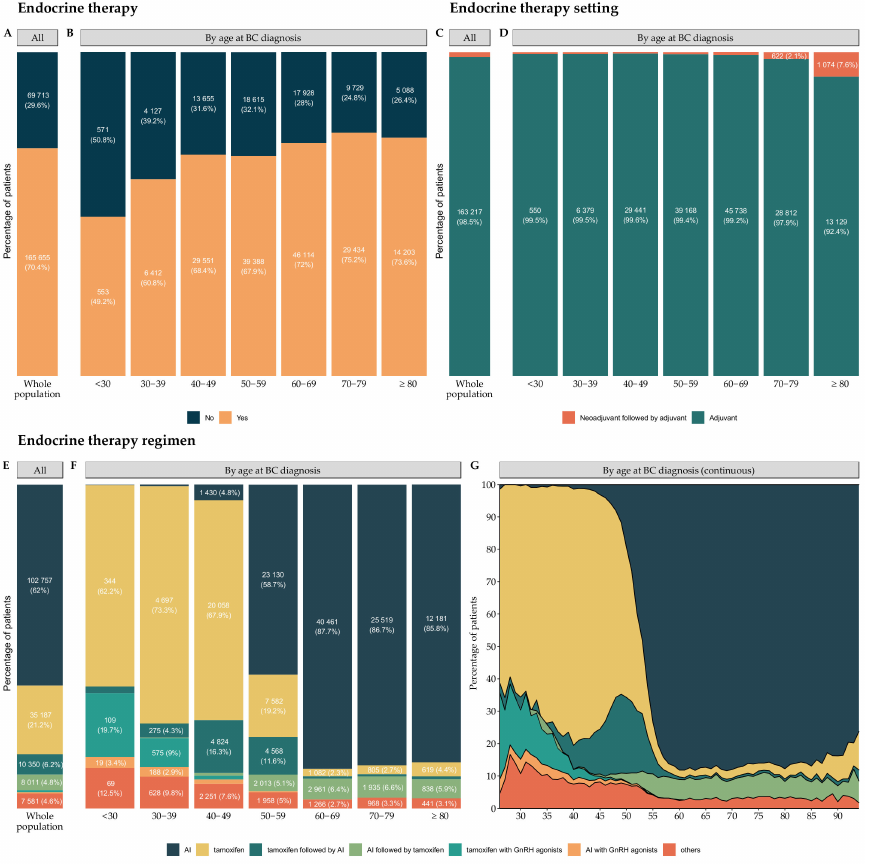
Figure 4. Endocrine therapy use, setting, and regimens, by age at BC diagnosis. ( A ) Endocrine therapy in the total population ( n = 235,368); ( B ) Endocrine therapy by age class at BC diagnosis; ( C ) Endocrine therapy setting in total population ( n = 165,655). Raw data for subgroups representing less than 2% of the total population are not displayed on the graph, to ensure readability: there were 2438 (1.5%) patients in the neoadjuvant followed by adjuvant group; ( D ) Endocrine therapy setting by age class at BC diagnosis. Raw data for subgroups representing less than 2% of the corresponding